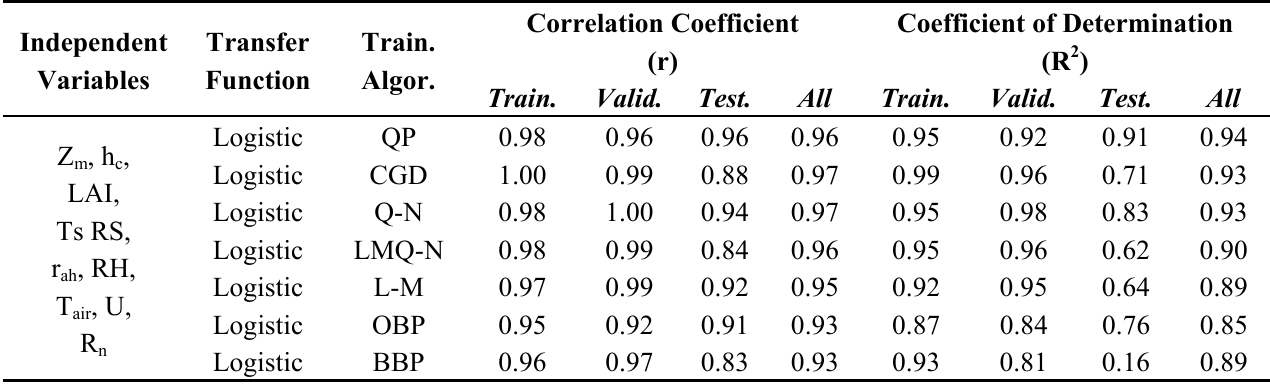
Table 2. Performance of the ANN model created using all independent variables and training algorithms.